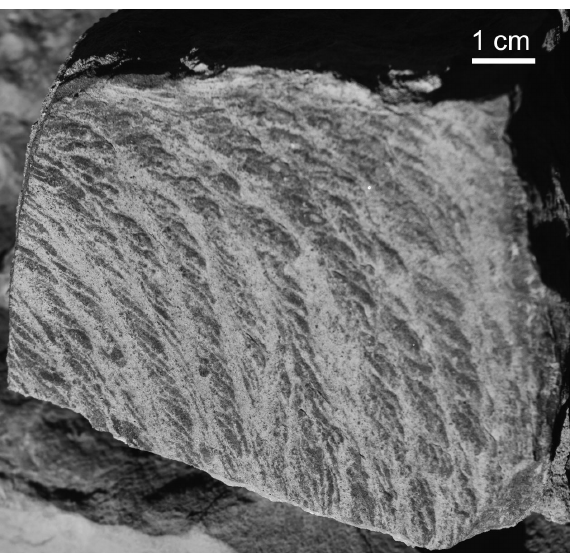
Fig. 4. Detailed view of second-order lamellae in Zoophycos from the Mélah Formation. Zoophycos isp. C Figure